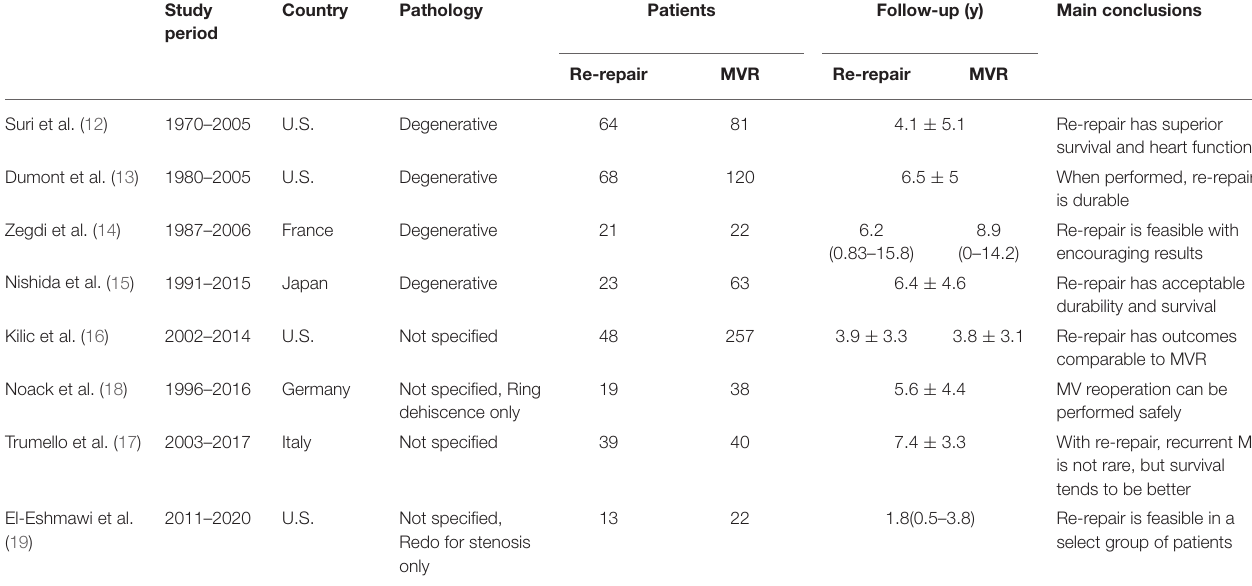
TABLE 1 | Basic characteristics of the included studies.